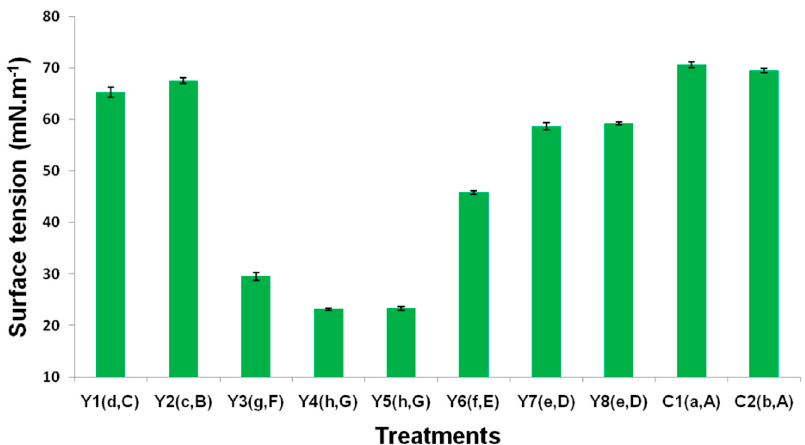
Figure 2. Surface tension values for the different treatments. Standard deviation of the means ( Ι ). “a,A”: The lower case and upper case letters in parentheses correspond to the differences between means of the LSD and Tukey tests, respectively. Electrolyte solution γ = 71.79 mN/m − 1 at 25 °C; culture medium γ = 71.93 mN·m − 1 at 25 °C.